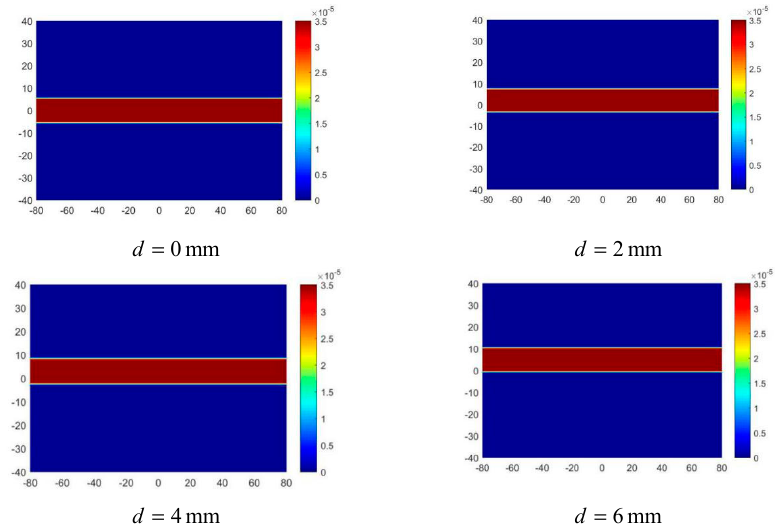
Figure 13. Imaging results of arterial blood flow profile with different d values.